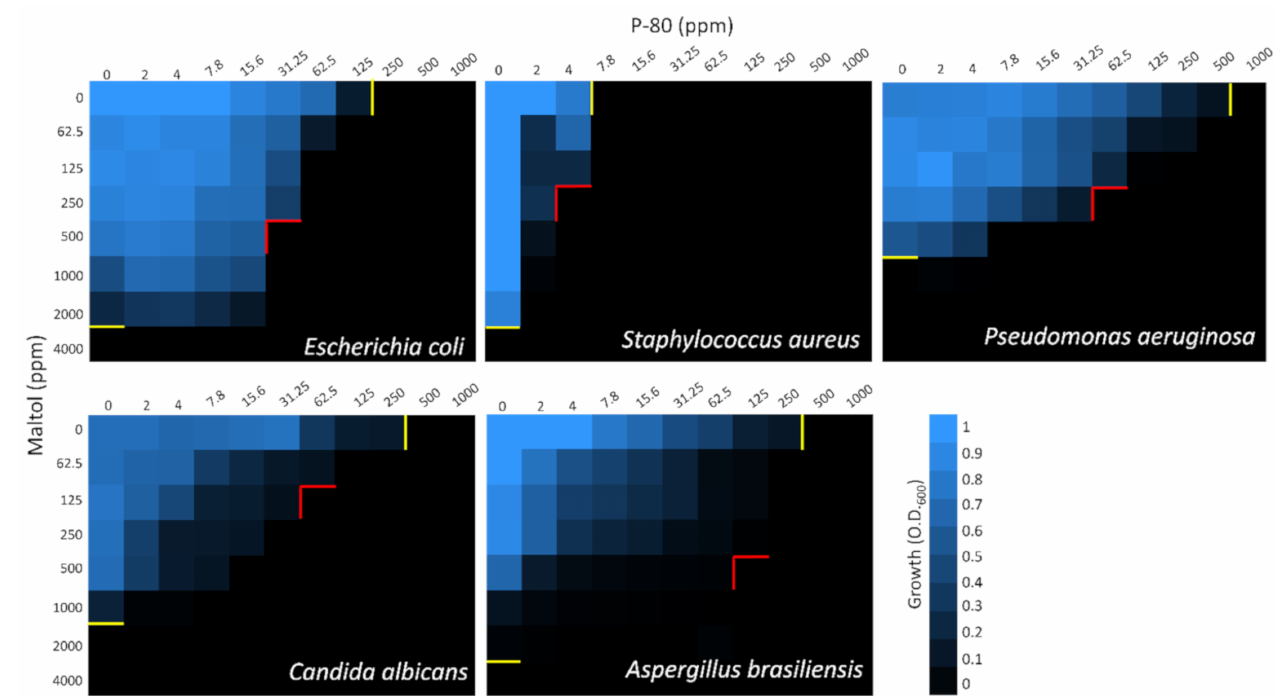
Figure 3. Checkerboard assay of maltol and P-80 against E. coli , S. aureus , P. aeruginosa , C. albicans, and A. brasiliensis . Growth measured after 24 h by O.D. 600 . On the X-axis, P-80 was diluted in a two-fold series dilution in a concentration range of 2–1000 ppm. On the Y-axis, maltol was diluted in a two-fold series dilution in concentrations range of 62.5–4000 ppm. Yellow lines indicate MIC 100 values of individual compound alone. Red lines indicate the optimal concentrations of the combined compounds. Final values are represented as the average relative growth in each well compared to blank, based on three independent